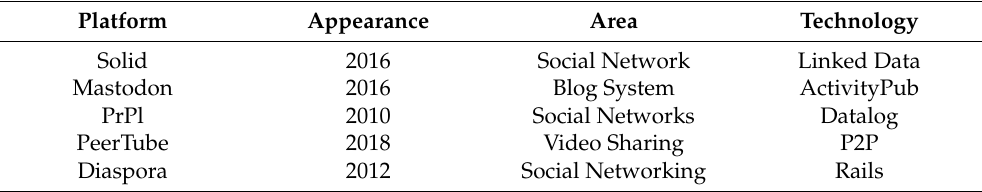
Table 1. Decentralized web technology comparison. Platform Appearance Area Technology Solid 2016 Social Network Linked Data Mastodon 2016 Blog System ActivityPub PrPl